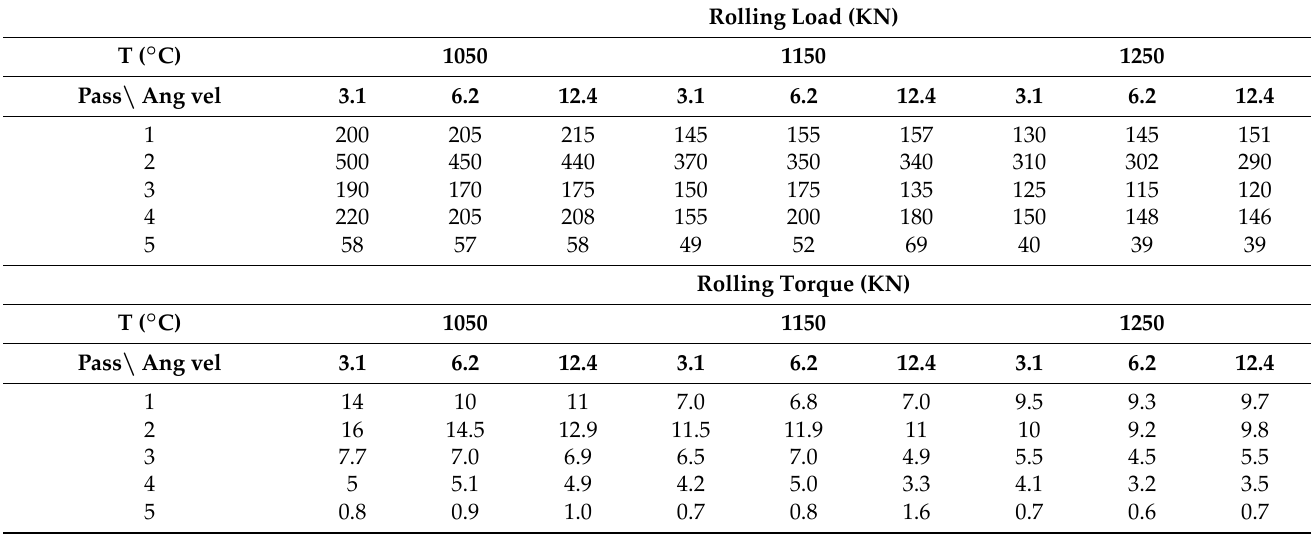
Table 4. Rolling loads and torques for each